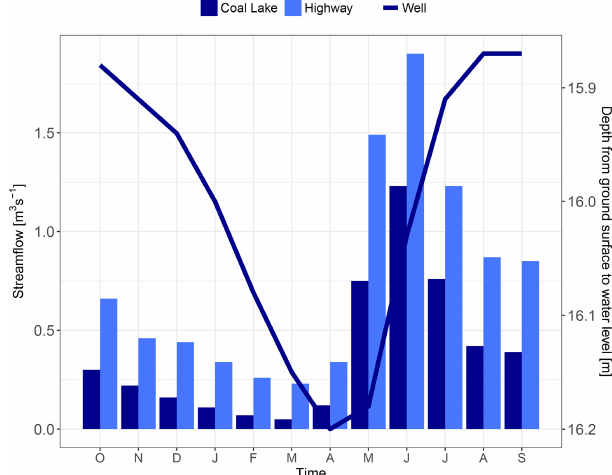
Figure 5. Water year cycle of streamflow at two Alaska Highway and Coal lake gauges, along with water levels in the groundwater well located in the forest biome within the Wolf Creek Research Basin.